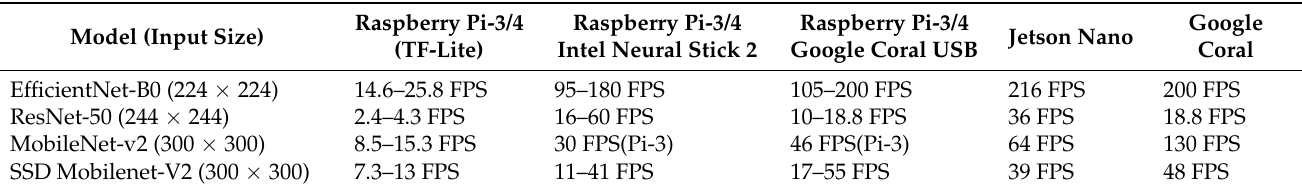
Table 4. TensorFlow performance using widely used image classification networks processed on different hardware in image frames per second (FPS) [7].